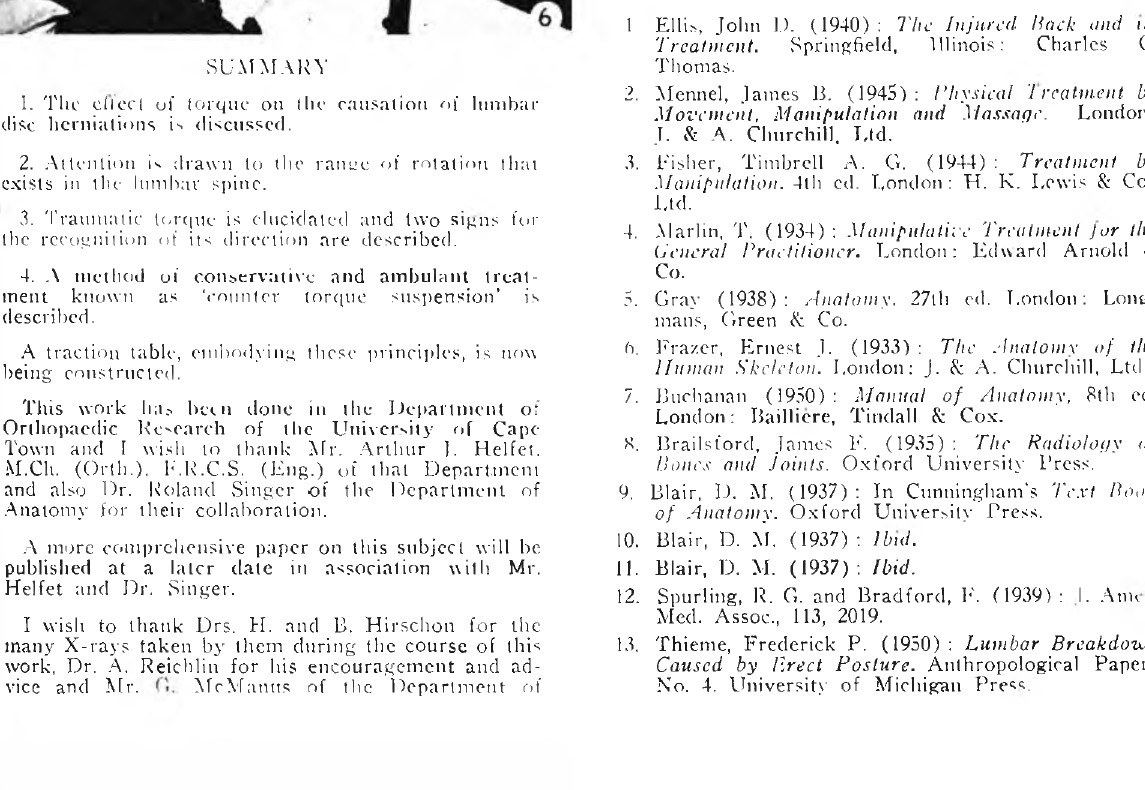
Surgcr\ at Oroote Schuur Hospital for the photo­ graphs. The torque belt was made to my design by A. H. Hodges & Co. (I’ty.) Ltd., 164 Sir T.owrv Road, Cape Town.